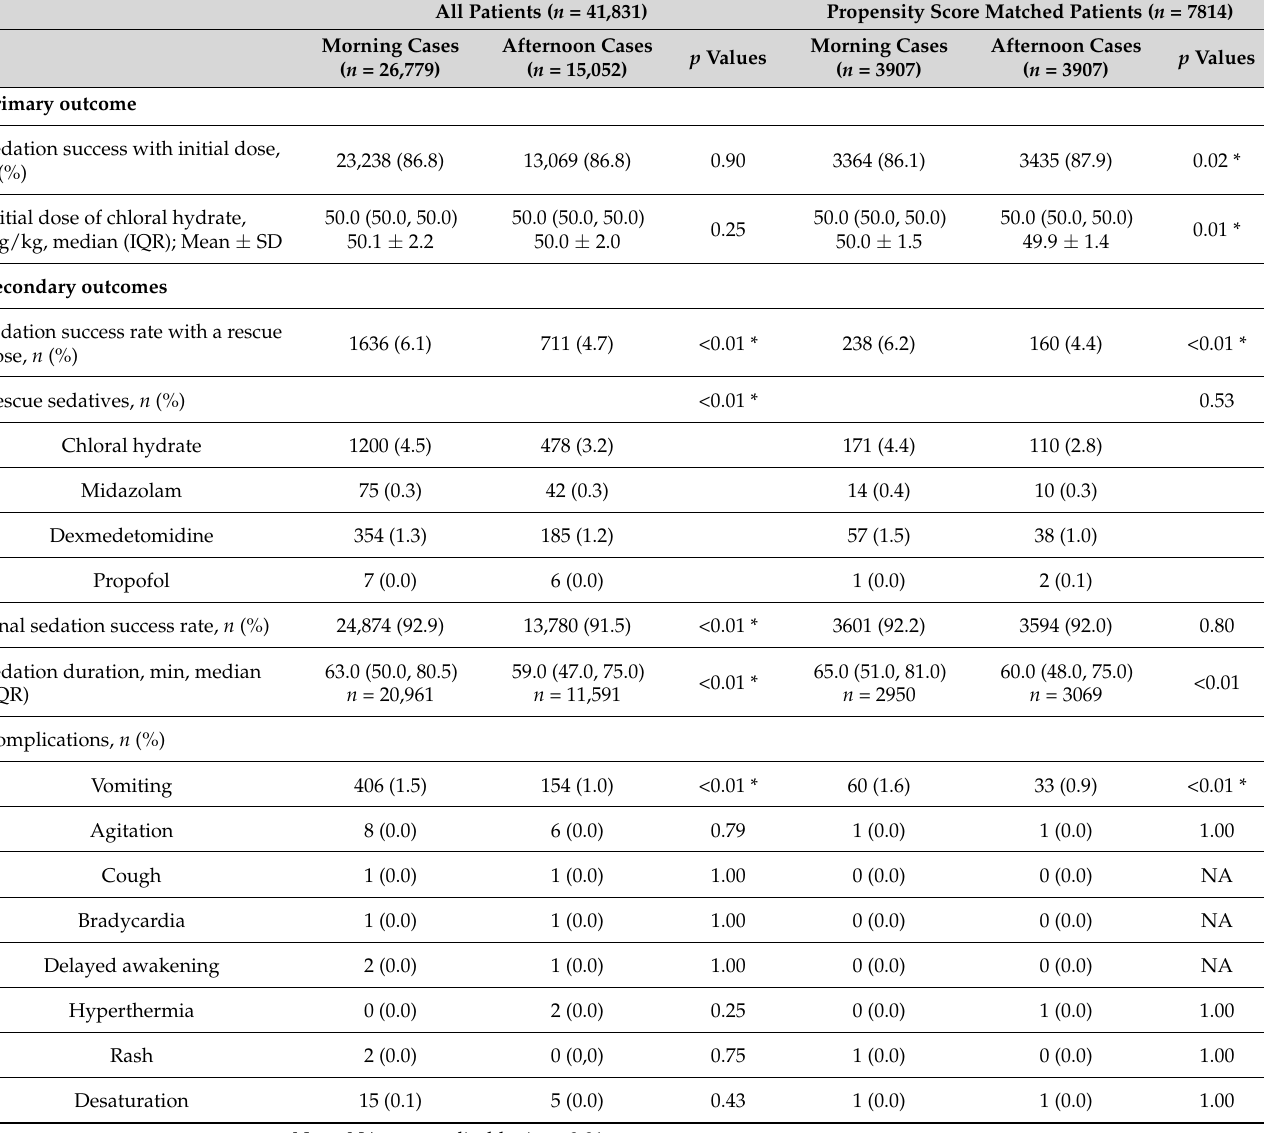
Table 2. Primary and secondary